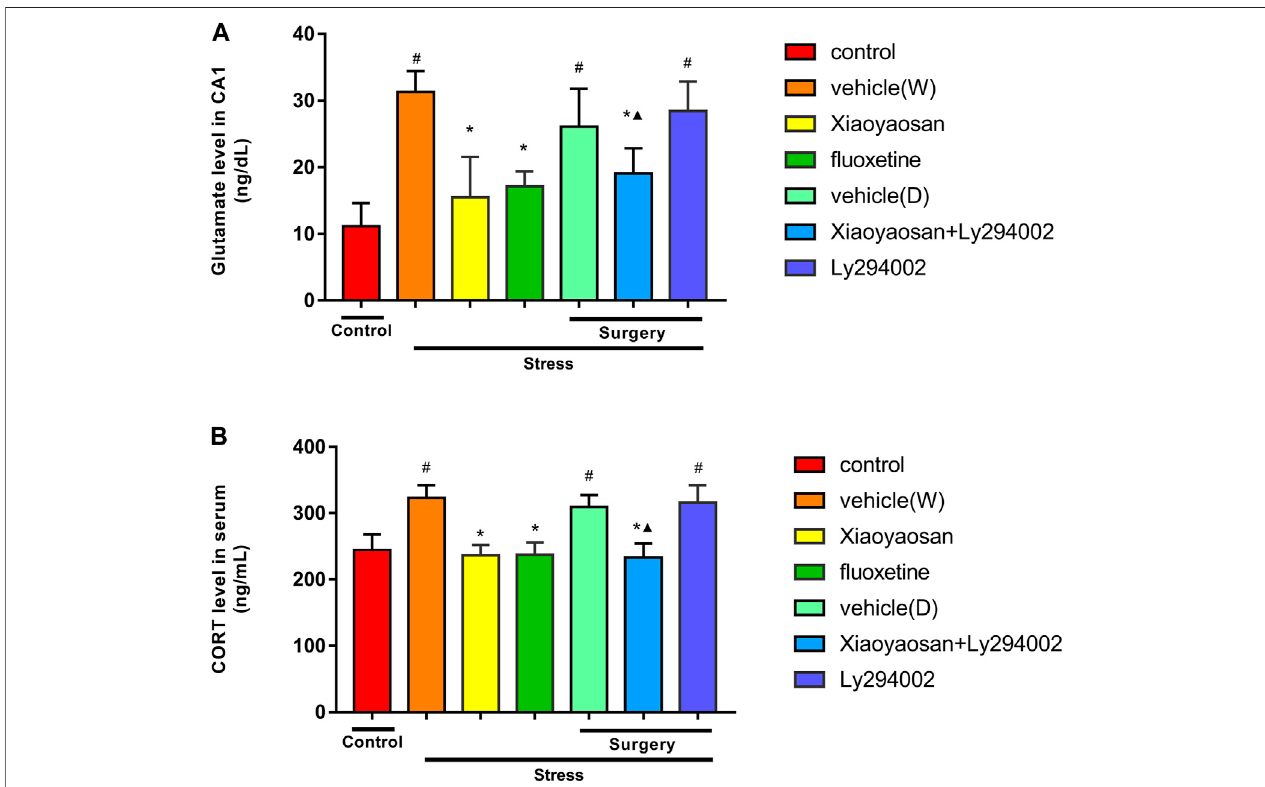
FIGURE4| LevelsofglutamateinthehippocampalCA1area (A) andCORTintheserum (B) inthetreatmentandcontrolgroupsofrats.Thedataareexpressedas the mean ± SD. # p < 0.05 compared to the control group; * p < 0.05 compared to the vehicle (W) group; ▲ p < 0.05 compared to the Ly294002 group, n (cid:2) 6.